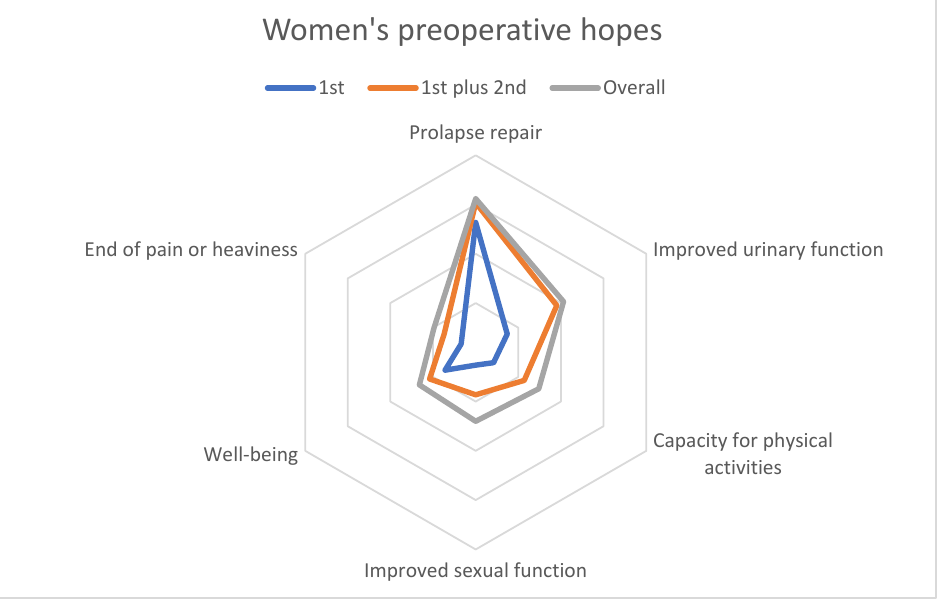
J. Clin. Med. 2023 , 12 , x FOR PEER REVIEW Figure 3. Women’s preoperative hopes. Figure 3. Women’s preoperative hopes.